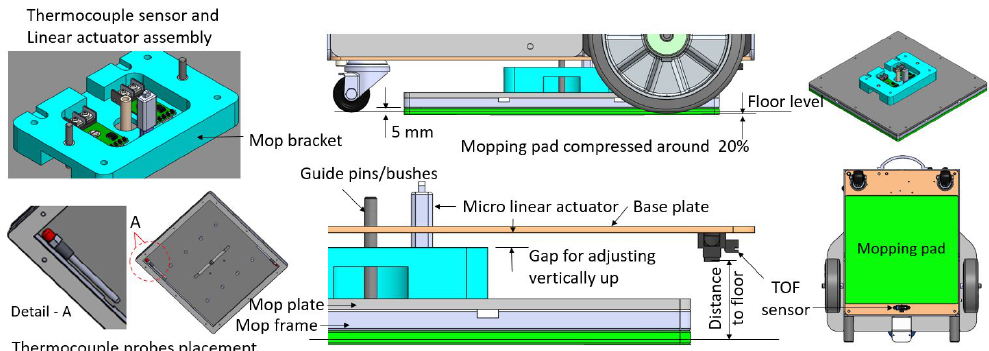
Figure 5. Mop temperature-monitoring and uniform floor contact system.